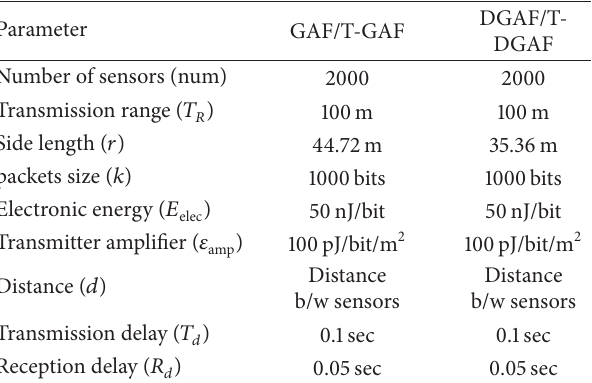
Table 2: Simulation